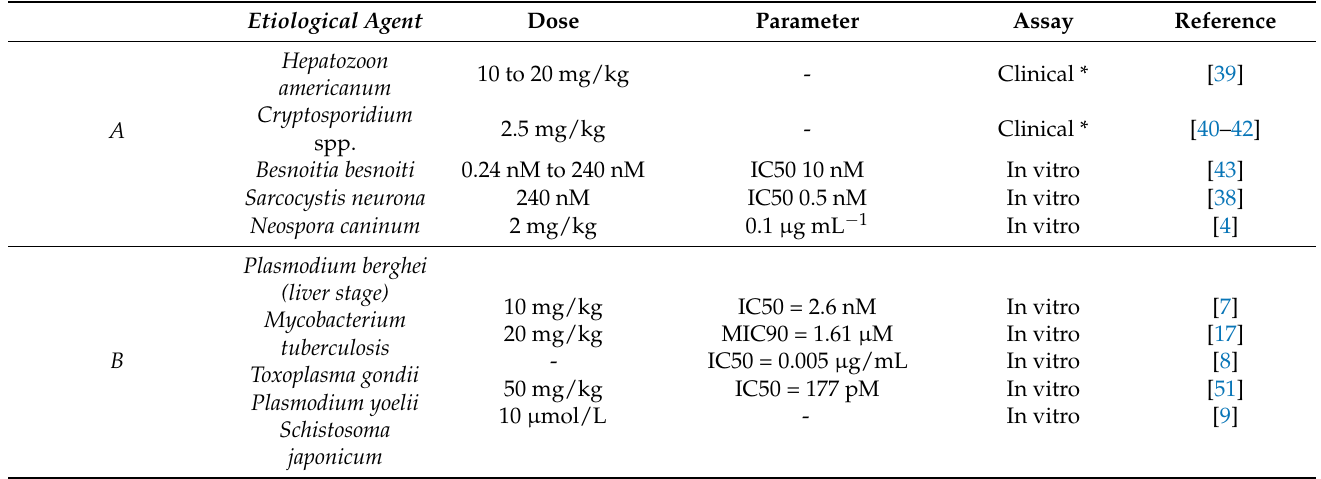
Table 1. (A) Common DQ dose regimen in clinical research or models evaluating it in animal cell cultures. (B) In vitro activity of DQ and its derivatives or models evaluating it against parasites infecting